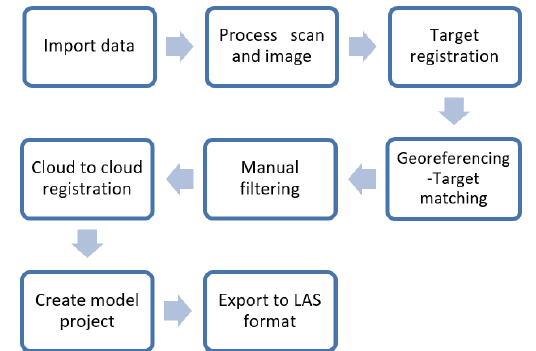
Figure 5: The procedure of pre-processing point cloud data